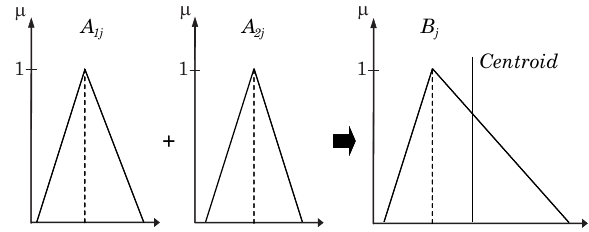
Figure 1. A fuzzy